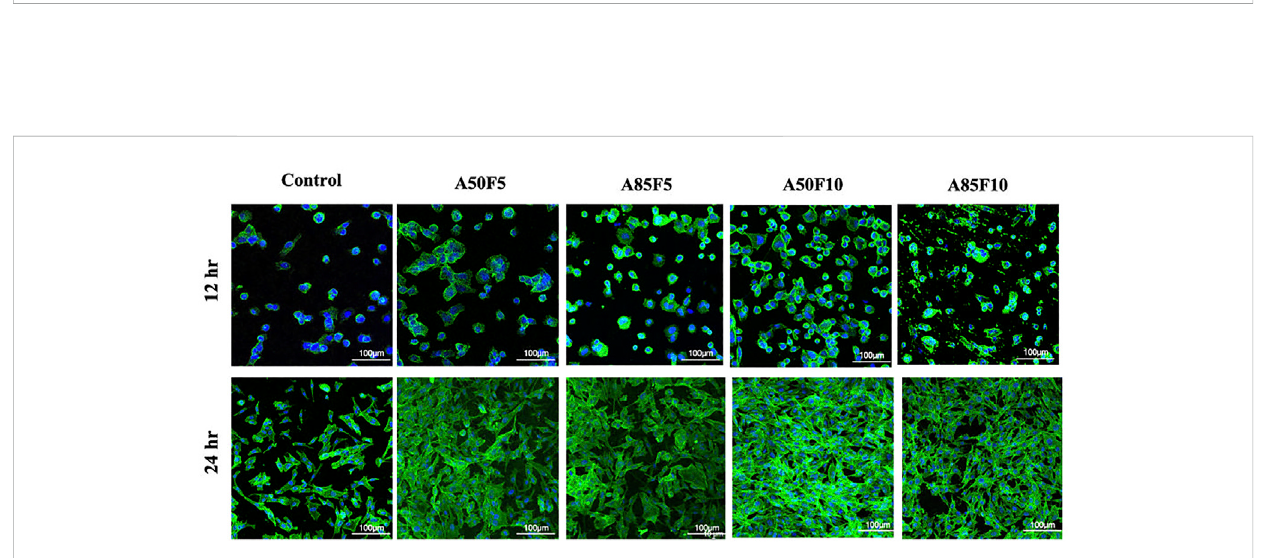
FIGURE 10 Confocal laser scanning microscopy (CLSM) images showing the cell proliferation on different surfaces of zirconia ceramic after culturing for 12 h and 24 h and demonstrating prominent cells adhesion and proliferation on 24